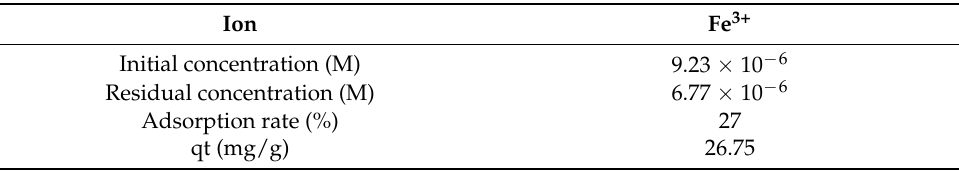
Figure 8. The standard curve for Fe 3+ (emission intensity corresponding to metal ion content) ( A ); variation of solution before and after adsorption of Fe 3+ by CAHG ( B ). Table 3. The ICP data of CAP hydrogel with Fe 3+ .